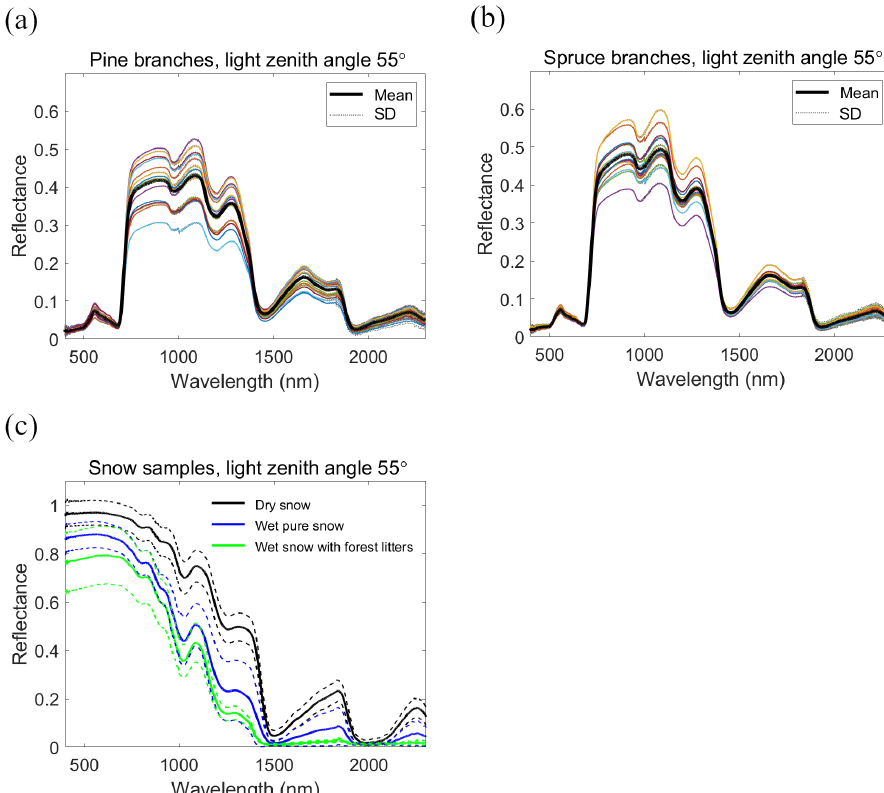
Figure 6. Reflectance spectra for (a) pine branches, (b) spruce branches and (c) three types of snow measured in dark laboratory conditions ± standard deviation. In (a) and (b) individual reflectance spectra for pine and spruce branches measured by shifting the sample box are presented, and the standard deviation is the deviation between consequent measurement acquisitions ( n = 20) averaged for each individual spectrum. In (c) the standard deviation is the deviation between different snow samples collected and measured from the same snow type